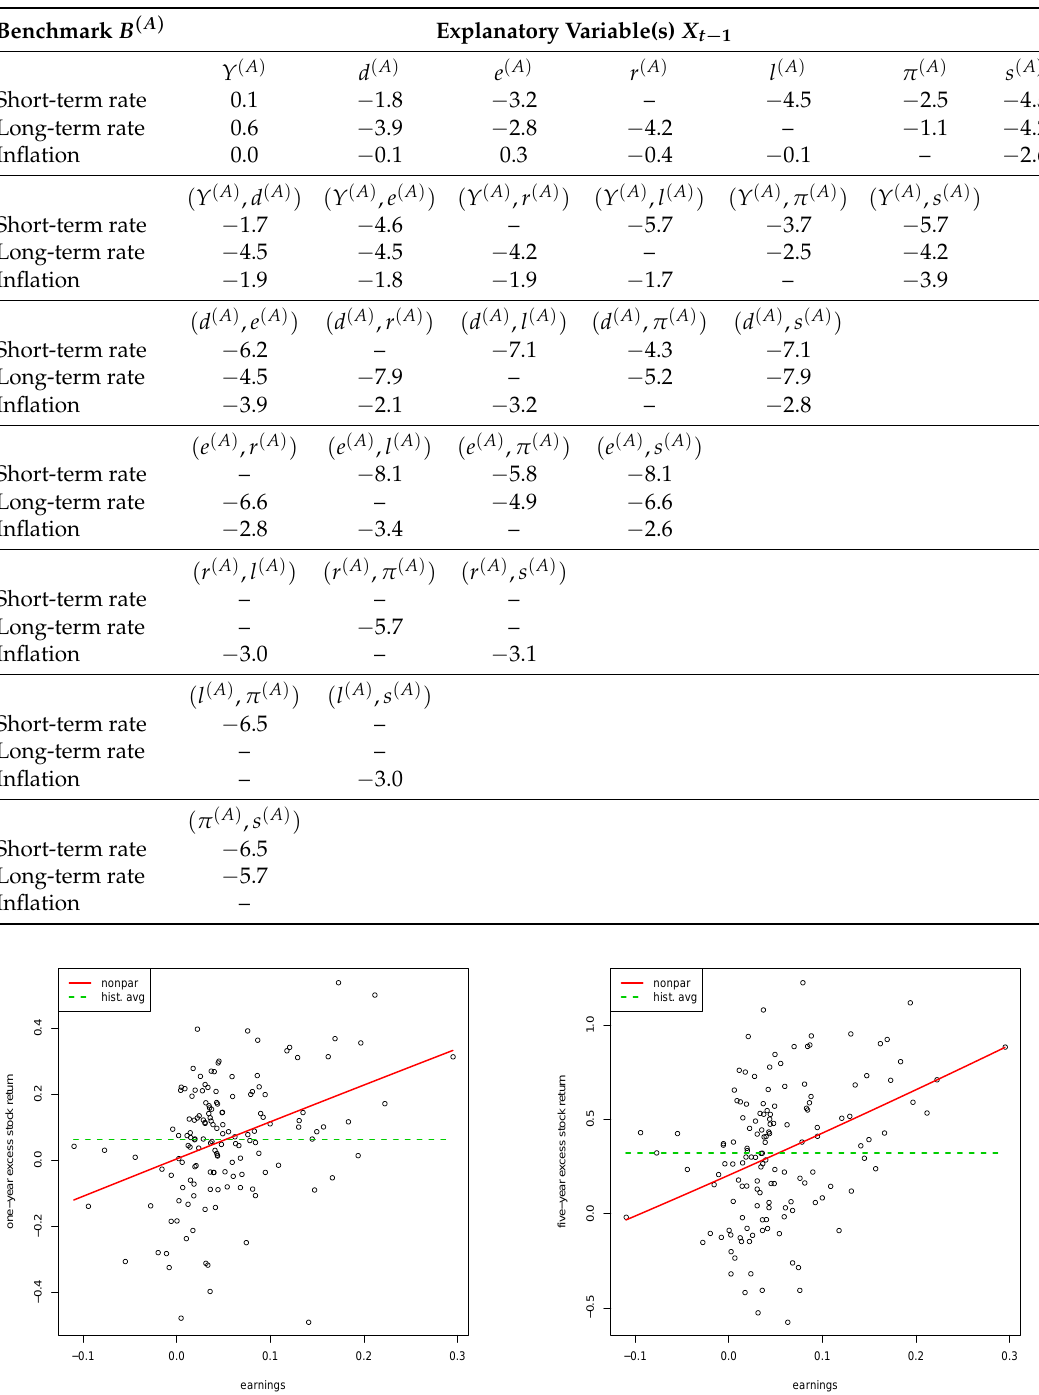
Table 7. Predictive power for the variance of five-year excess stock returns Z benchmarking approach for the conditional mean model with earnings-by price as single covariate. The prediction problem is defined in (15). Additional notes: see Table 6.